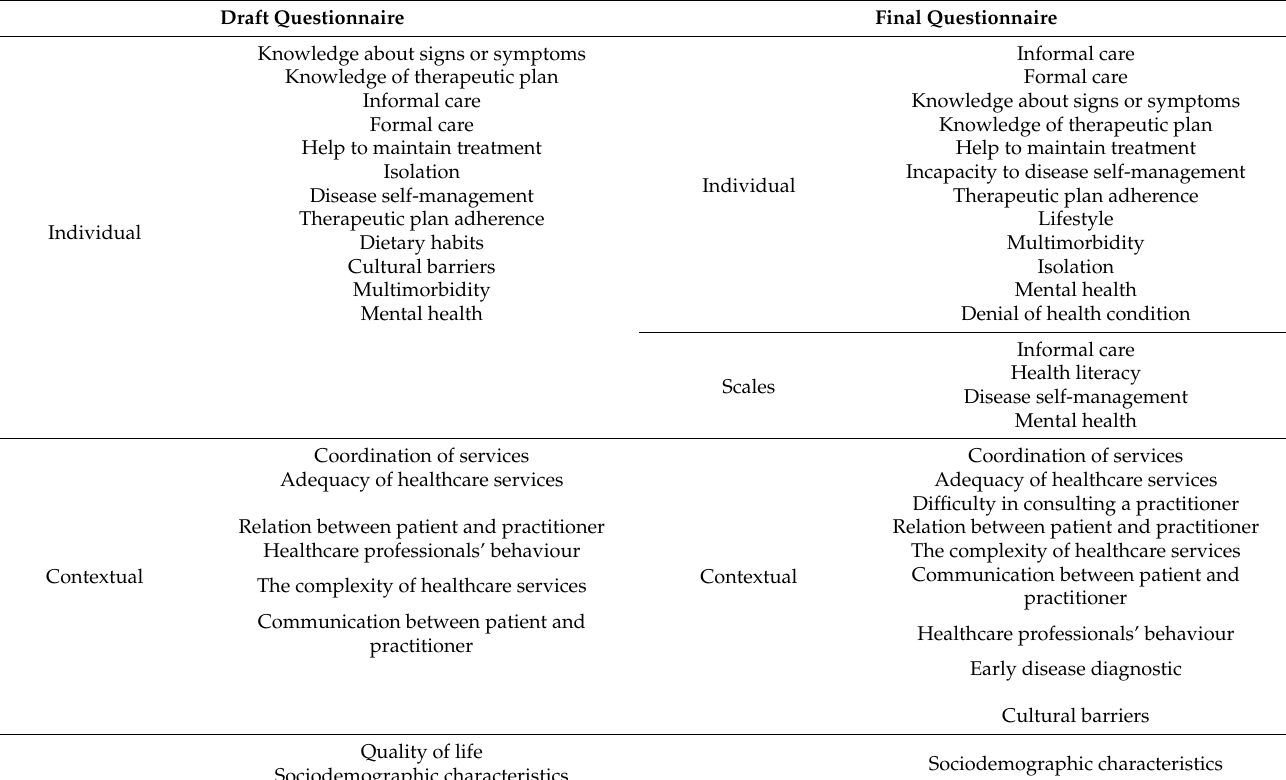
Table 4. Evolution of the list of determinants used on the